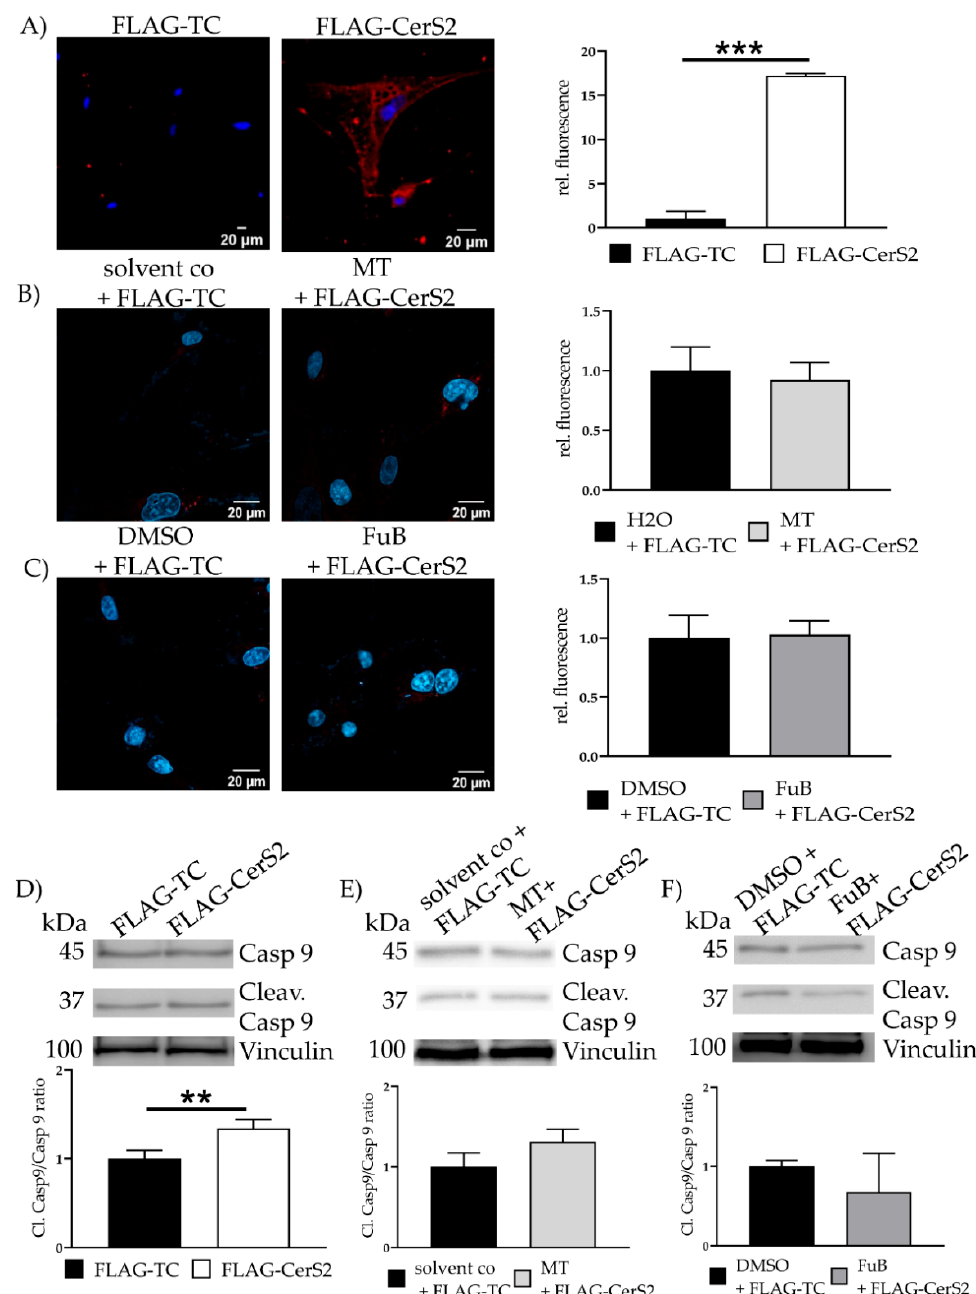
Figure 10. Apoptosis Initiation—Cytochrome C and Cleav. Casp 9 protein level in FLAG- CerS2. ( A ) Cytochrome c delocalization from mitochondria to cytoplasm visualized with IF. Cytochrome c was stained with red. Nucleus was stained blue. Shown are two representative images ( B ) Cells were pre-treated with MT and transfected afterwards. Cytochrome c delocalization from mitochondria to cytoplasm visualized with IF. Cytochrome c was stained with red. Nucleus was stained blue. Shown are two representative images ( C ) Cells were pre-treated with FuB and transfected afterwards. Cytochrome c delocalization from mitochondria to cytoplasm visualized with IF. Cytochrome c was stained with red. Nucleus was stained blue. Shown are two representative images. ( D ) WB analysis of cleaved caspase 9/caspase 9 ratio in FLAG-CerS2. Shown is one representative blot. ( E ) WB analysis of MT pre-treated FLAG-CerS2. Depicted is one representative blot. ( F ) WB analysis of FuB pre-treated FLAG-CerS2. Depicted is one representative blot. Depicted are the mean values and standard deviation of minimum three biological replicates. Significances were calculated with a t -test. (** p ≤ 0.01, *** p ≤ 0.001).